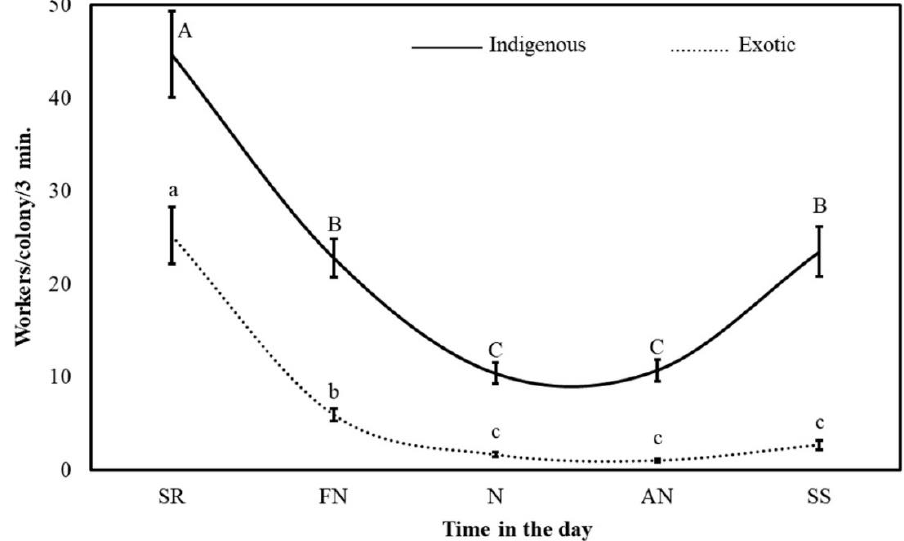
Figure 5. The hourly pollen-gathering rates (mean ± SE) of indigenous ( Apis mellifera jemenitica ) and exotic ( A.m. carnica ) honeybee colonies during the Acacia gerrardii flow (May–August) in the 2017 and 2018 seasons in Central Arabia. (SR: sunrise; FN: forenoon; N: noon; AN: afternoon; SS: sunset). The same letter in the same chart line are not significantly ( p ˃ 0.05) different.